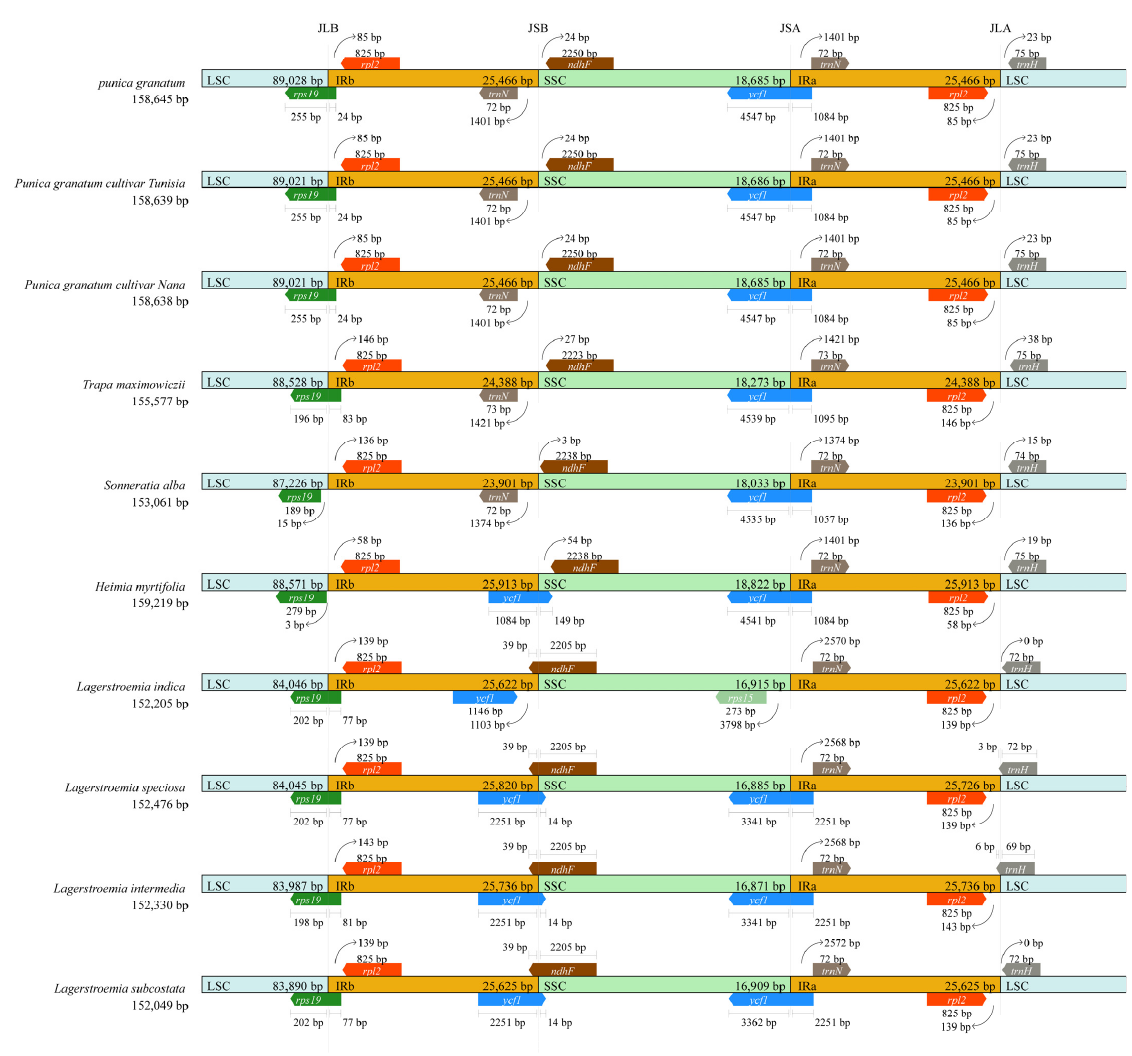
Figure 5. Illustration of the borders and analysis of LSC, SSC, and IRs regions among demonstrative wild pomegranate chloroplast genomes. The relative information of the genes is presented by boxes. The cp genomes of wild pomegranate and nine other species related family of Lyth- raceae were compared by using Mauve alignment (Figure 6). The results displayed that in two cultivars ‘Tunisia and Nana’ the genomic sequences display perfect homology conserva- tion with no inversion or rearrangements with wild pomegranate, as shown in Figure 6, con- firming that gene distribution and gene structure are highly similar to each other. While other species have shown slight differences with wild pomegranate cultivars but are very close, it may be because of the evolutionary relationship between these chloroplast ge- nomes of the species have to face some hurdles and may need some time for the recovery process.